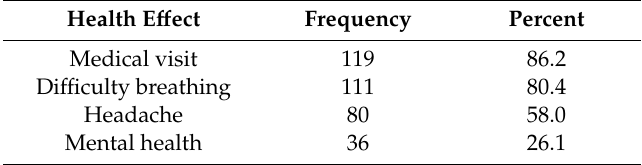
Table 2. Health outcomes experienced by IEHs in relation to air